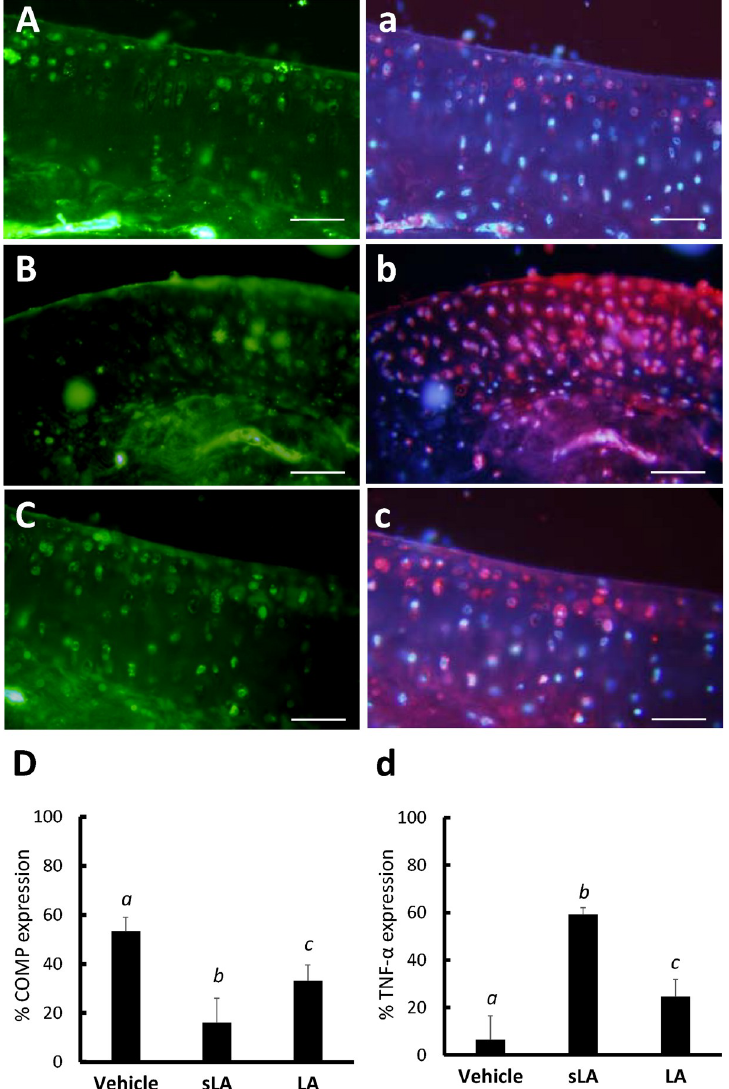
Fig 5. The immunofluorescent expressions of COMP (Alexa Fluor 488-green) and TNF- α (Alexa Fluor 594-red) immunoreactivity in the vehicle control (A and a), CFA combined with sham-operation (sLA, B and b) and laser acupuncture (LA, C and c) groups, respectively. The level of COMP- and TNF- α -like immunoreactivity were counted in five randomly selected high-power fields ( × 200) in each section (D and d). The bar graph shows a statistical difference in the COMP- and TNF- α -like immunoreactive cells among the vehicle control, sLA and LA groups. A decrease in COMP expression and elevation in TNF- α expression in the cartilage from the sLA group were noted compared with the vehicle control and LA groups. Each value represents the mean ± SD. Different italic letters indicate significant differences between groups using Scheffe’s post hoc test (P < 0.05). A scale bar indicates 50 μ m.